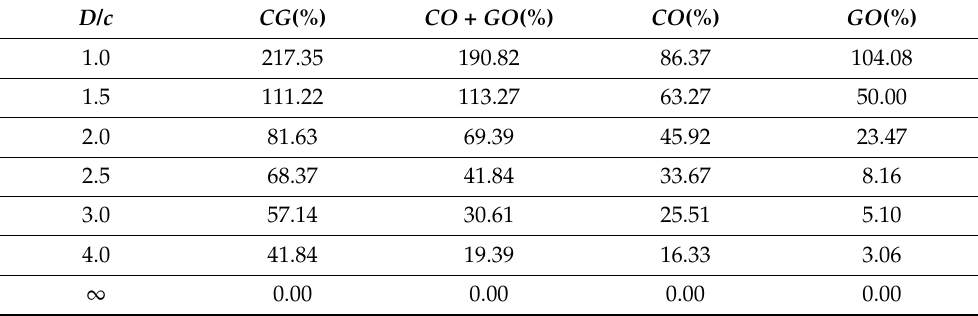
Figure 6. The relative increment of cycled-averaged lift coefficient relative to the D / c = ∞ case (cid:0) (cid:1) C L − C L ∞ (expressed as / C L ∞ ) for the combined ceiling and ground case (referred to as CG ), the ceiling-only case (referred to as CO ), and the ground-only case (referred to as GO ) and the sum of the ceiling-only case and the ground-only case (referred to as CO + GO ) versus ( D / c ) at Re = 10. Table 1. The relative increment of cycled-averaged lift coefficient relative to the D / c = ∞ case ceiling and ground case, the sum of the ceiling-only case and the ground-only case, the ceiling-only case and the ground-only case,